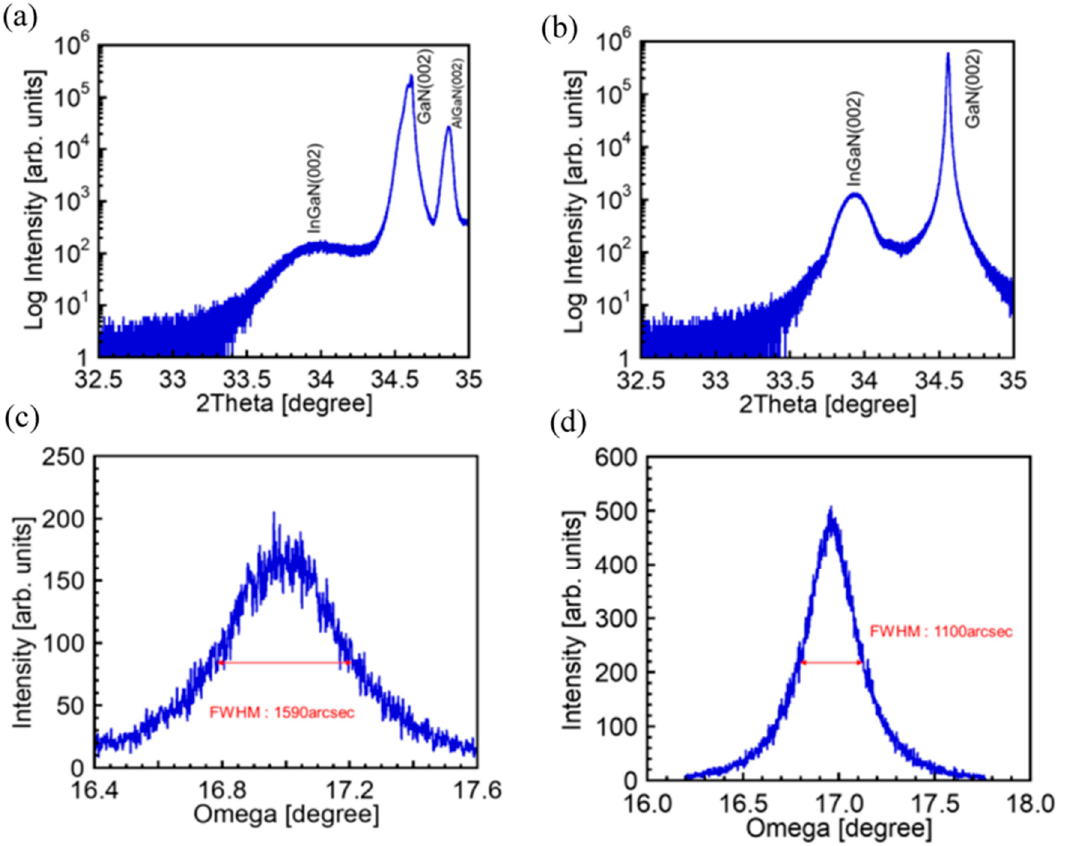
Figure 2. XRD 2theta-omega scan of the (002)-plane for the InGaN/GaN heterostructures at the growth temperature of 760 °C both on the ( a ) AlGaN/GaN-on-Si HEMT and ( b ) GaN/sapphire template. Corresponding XRD rocking curves of InGaN epitaxial layers on the ( c ) AlGaN/GaN-on-Si HEMT and ( d ) GaN/sapphire template, respectively.